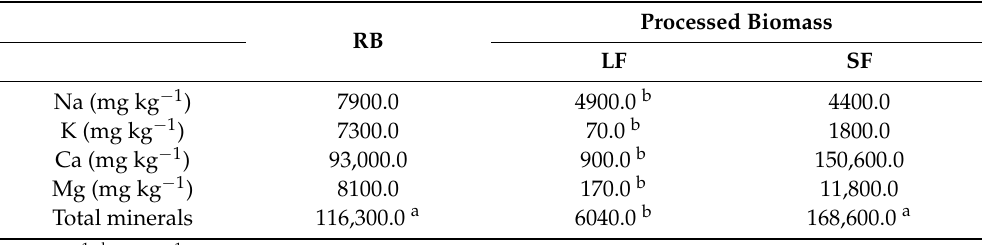
Table 4. The inorganic elemental analysis of raw (RB) and processed Sargassum spp. biomass from the Mexican Caribbean: liquid (LF) and solid fractions (SF) on a dry basis ( n = 1). Processed Biomass RB LF SF Na (mg kg − 1 )